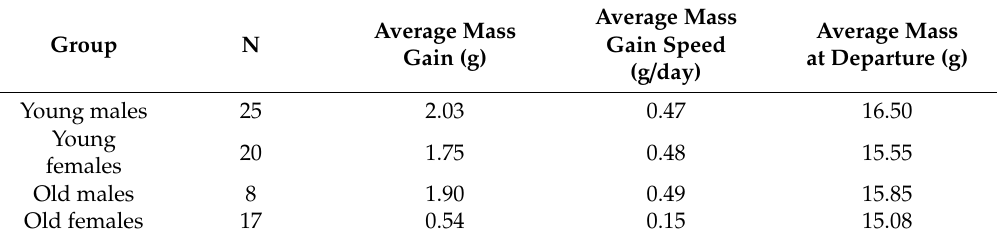
Table 2. The average mass gain and mass gain speed for each of the four age groups.